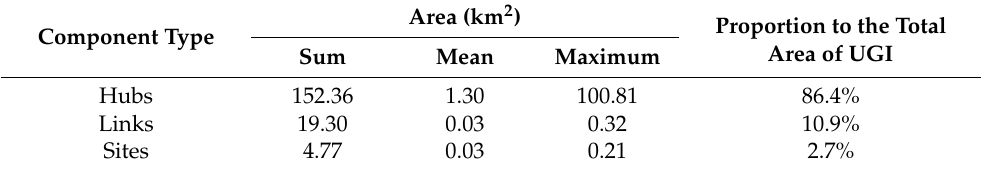
Table 6. Component statistics of UGI spatial pattern.